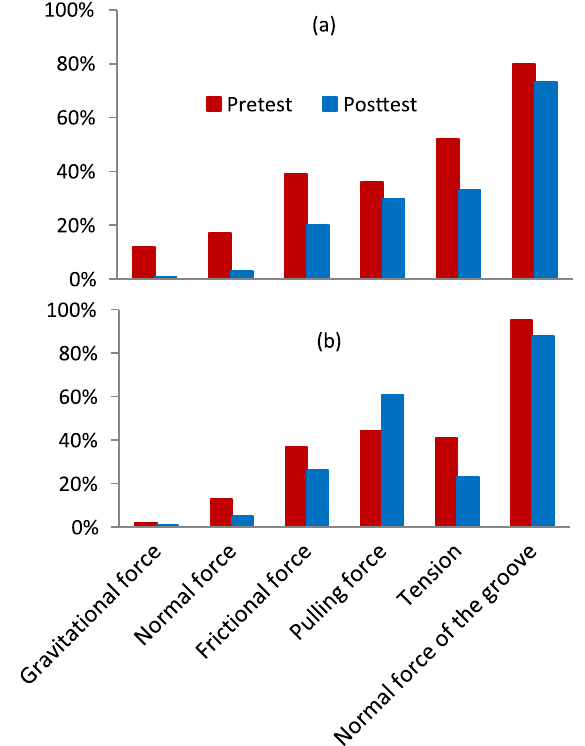
FIG. 2. Percentage of occasions in which the first tiers of the corresponding items have been correctly solved, but the force has been named incorrectly or not named at all: (a) experimental group, (b) control